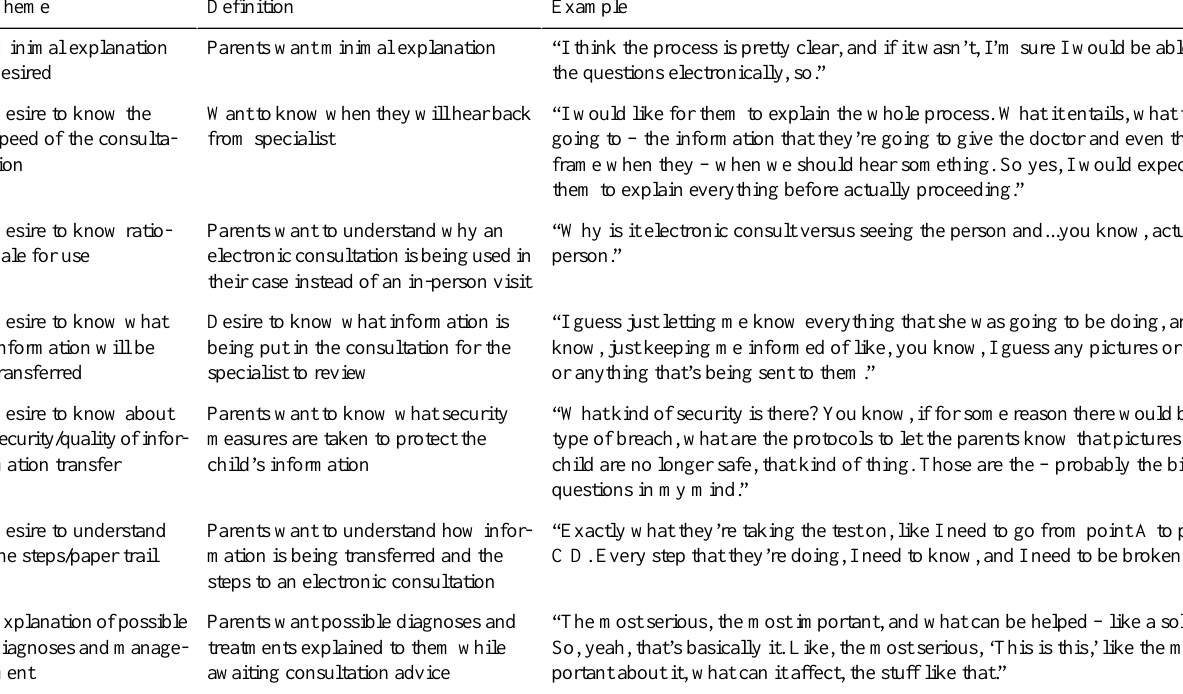
Table 3. Parent perspectives on information they would like to receive at the time of pediatric electronic consultation.